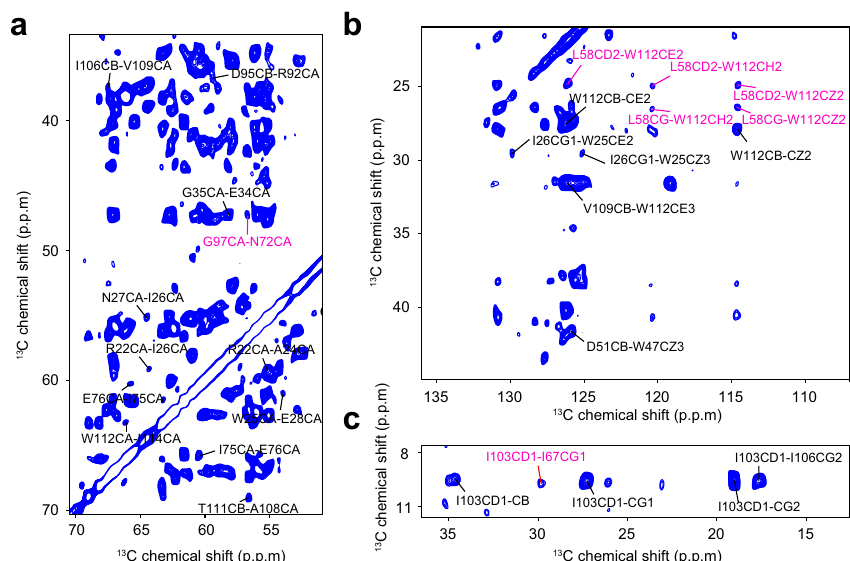
Fig. 1 ssNMR spectra of the 13C sparsely labeled DgkA samples. a, b Portion of the 2D 13 C – 13 C DARR spectra recorded on 2-glycerol- 13 C – 15 N-labeled DgkA samples for assigning the 13 C – 13 C distance restraints. Peaks with an unambiguous assignment are labeled and those corresponding to long-range contacts are highlighted in magenta. c Region of the 2D 13 C – 13 C DARR spectra of 1,3-glycerol- 13 C – 15 N-labeled DgkA sample used for assigning the 13 C – 13 C distance restraints. Assigned peaks are labeled and those corresponding to long-range contacts are labeled in magenta.